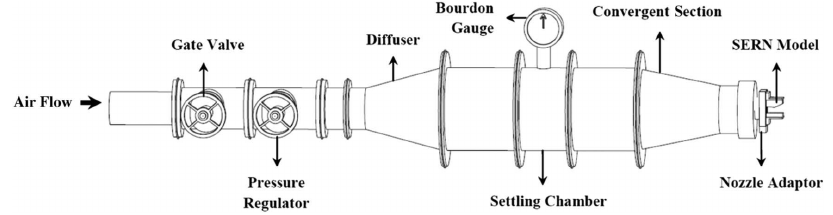
Figure 1. Schematic representation of the open jet facility [28].